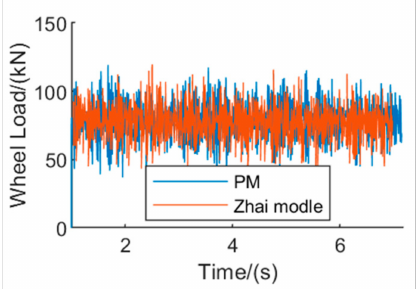
Figure 4. Comparison of calculation results for a single